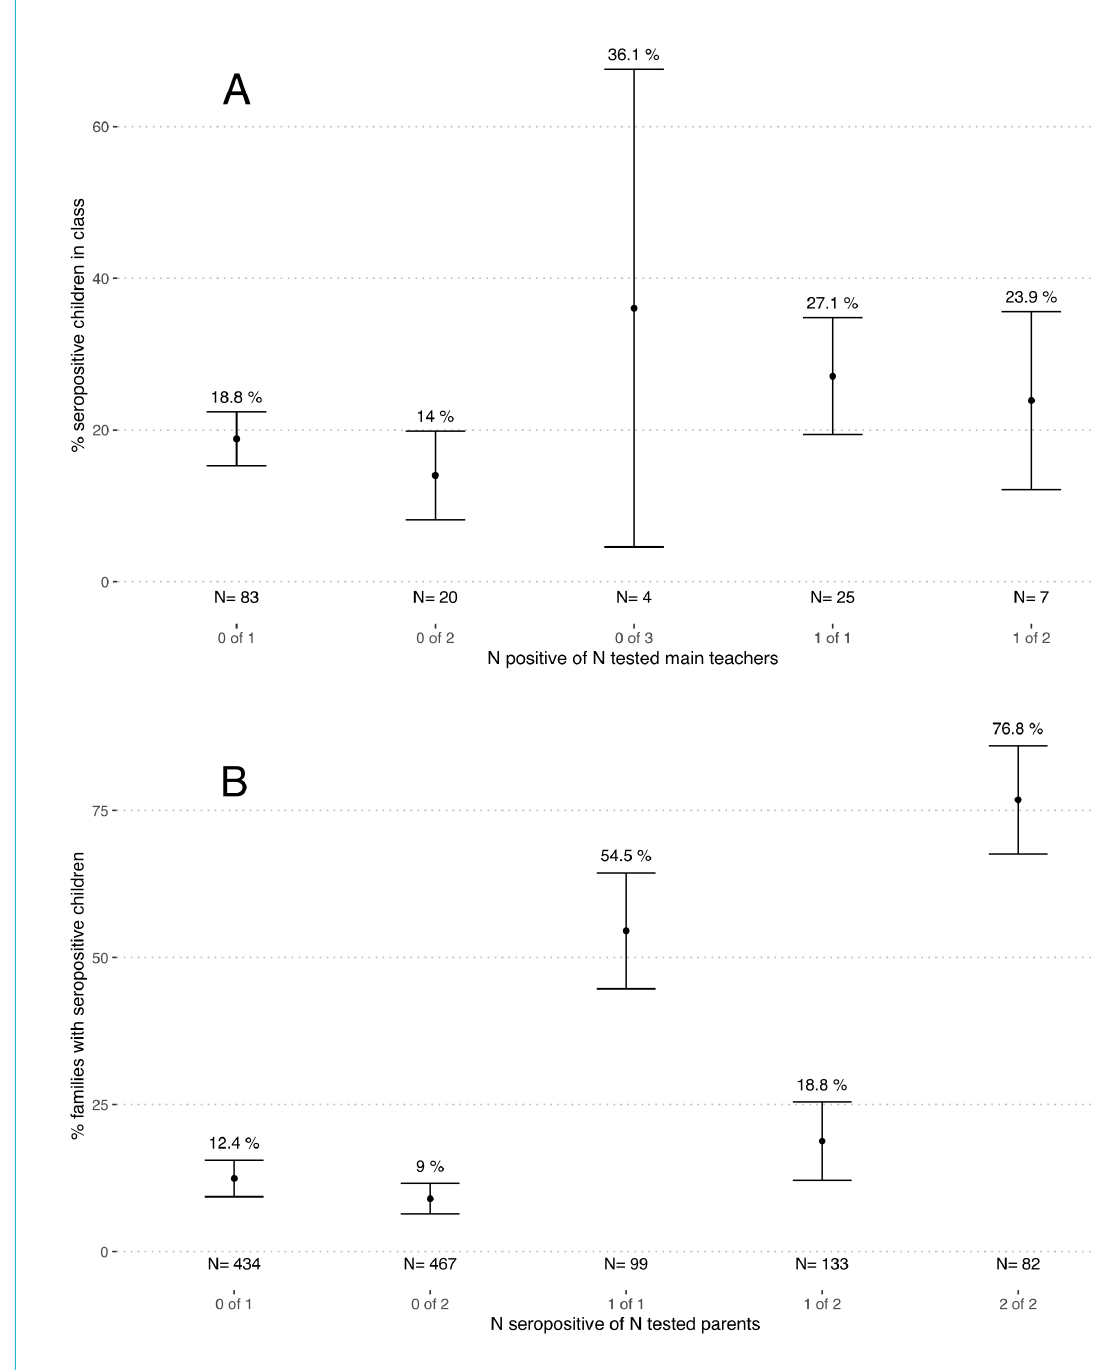
Figure S2: Proportion of seropositive children in classes and families depending on the number of tested and seropositive main teachers and parents in March-April 2021. A – classes with at least one main teacher and 4 children tested. Numbers (N) below graphs correspond to the numbers of classes in the category. B – families with at least one child and one parent tested. Numbers (N) below graphs correspond to the numbers of families in the category. Note: the name of the category, written in grey below the number of classes or families tested,written in grey below the number of classes or families tested, tells how many teachers (parents) were tested in a class (family) from the total tested within that class (family). E.g., “0 of 1” signifies classes where a single main teacher was tested, with test result seronegative. We do not show two classes with 3 main teachers tested, as confidence intervals could not be estimated for single data